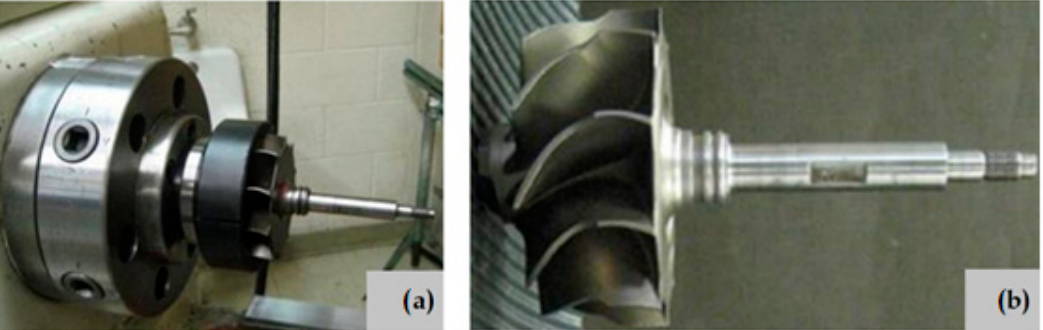
Figure 12. ( a ) Bellino Srl Company and ( b ) Keller und Knappich Augburg Company (KUKA); friction welding of Axles (China RCM).